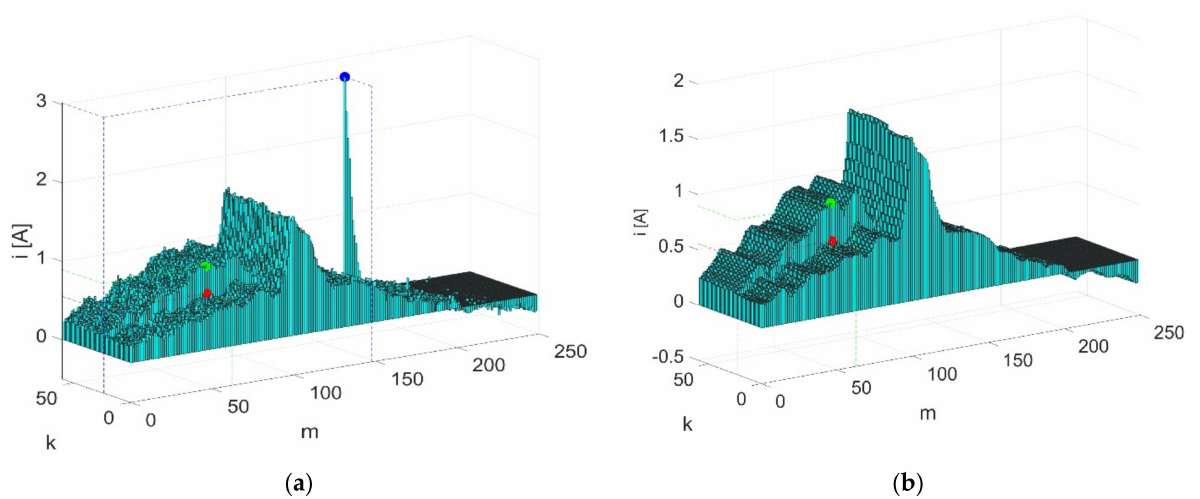
Figure 5. An example of changes in a pseudo-periodic signal caused by the inclusion of an additional appliance. ( a , b ) represent the same event. The signal on ( a ) array IP was not filtered, the signal on ( b ) array I was filtered by the 15th order median